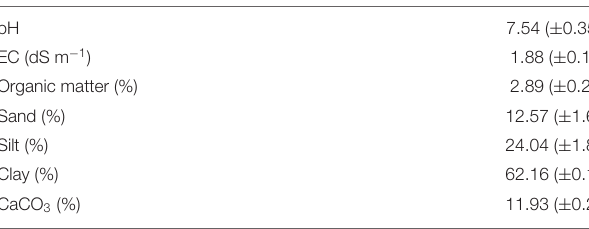
TABLE 1B | Vertisol